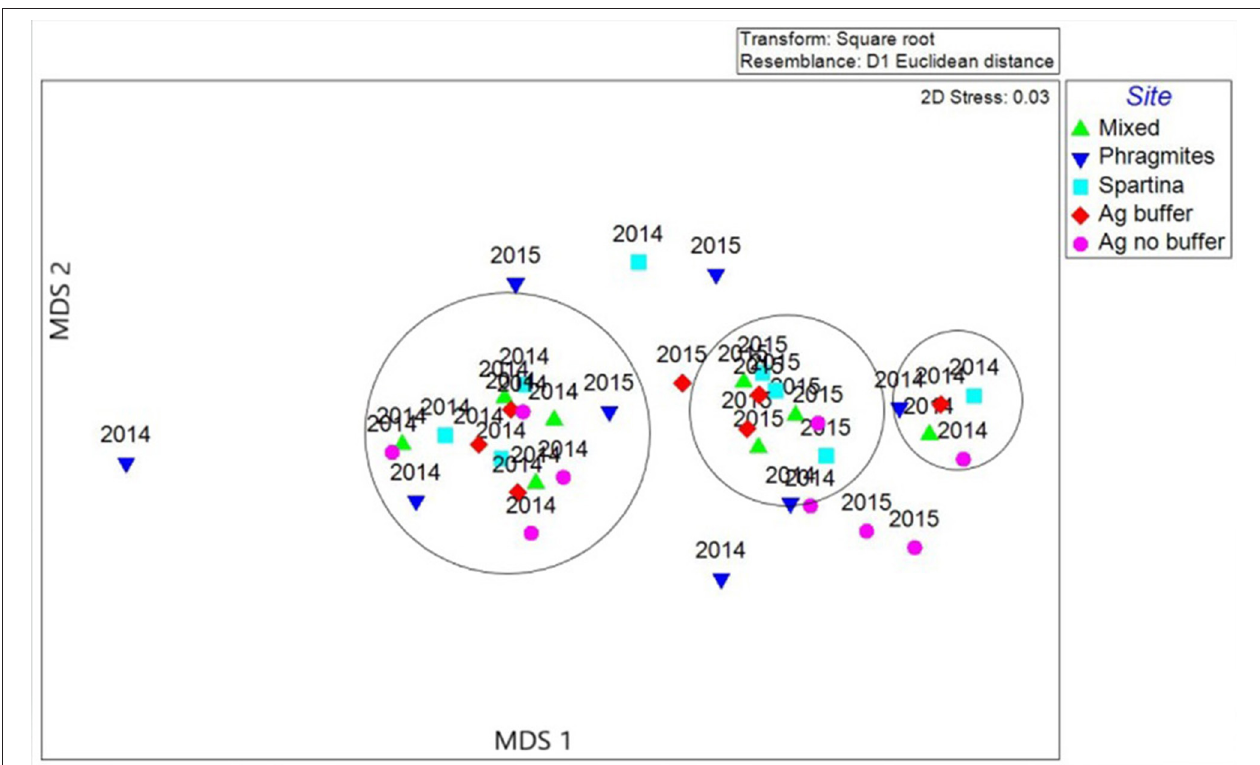
FIGURE 8 | Multidimensional analysis to study the similarities of the study sites for heavy metals during 2014 and